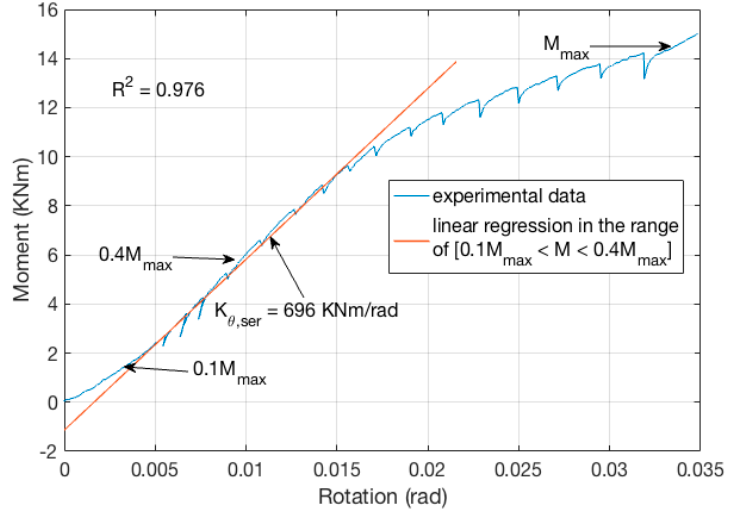
Figure 5. Linear interpolation of the moment-rotation diagram between 10% M max and 40% M max